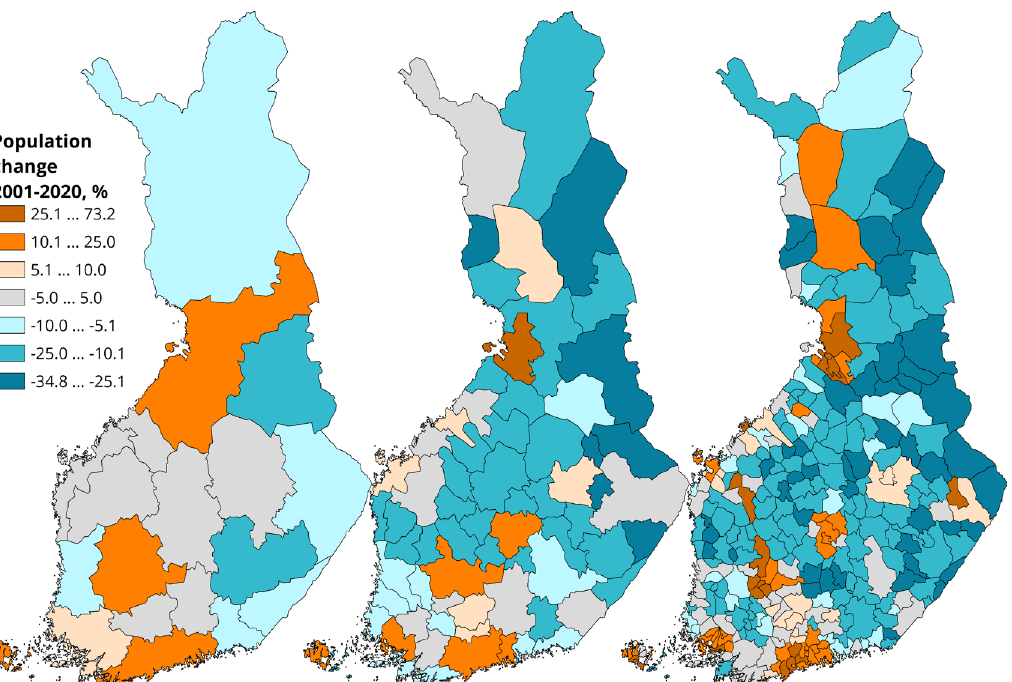
Fig. 3. Population changes of Finnish regions,